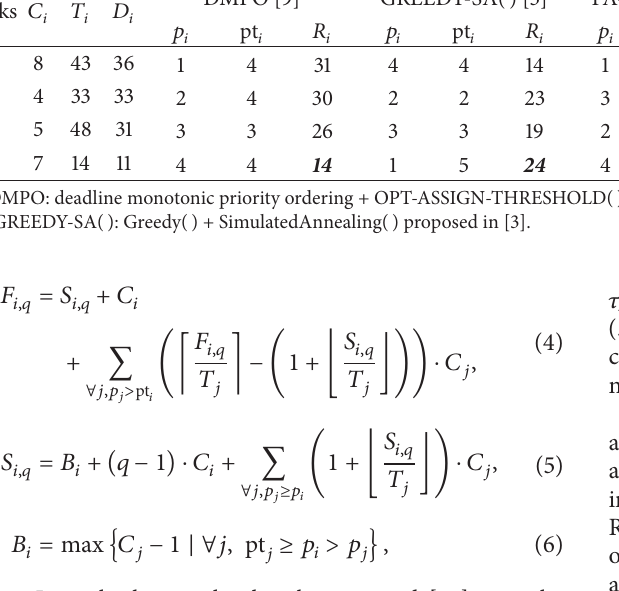
Table 1: A walk-through example task set. Bold and italic 𝑅 𝑖 ’s represent infeasible response times. Tasks 𝐶 𝑖 𝑇 𝑖 𝐷